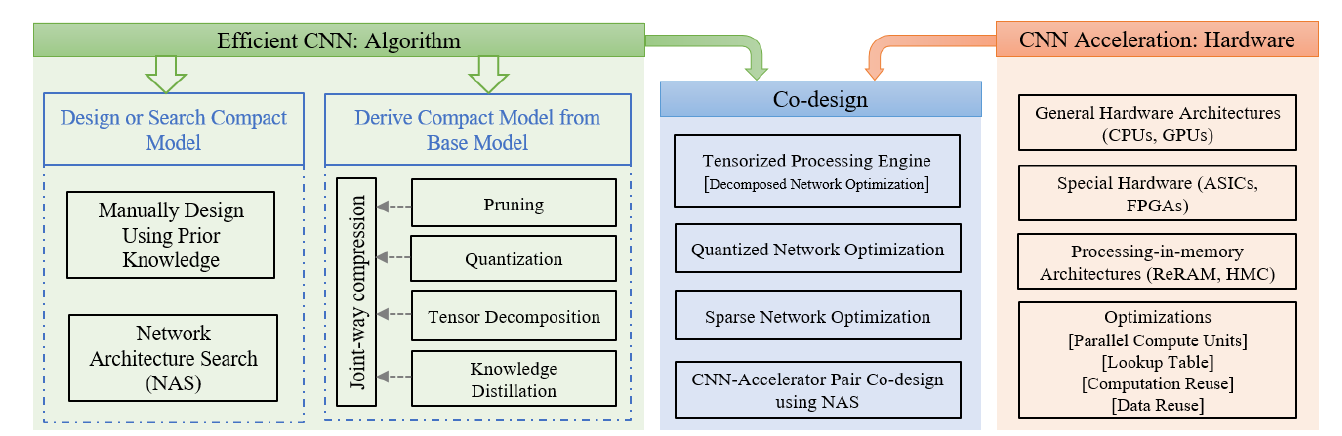
Figure 2. Overview of efficient CNN design